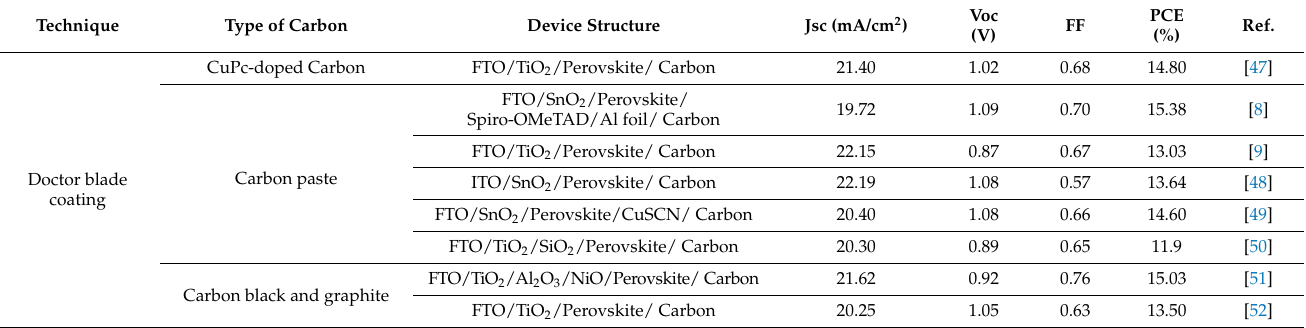
Table 1. Summary of several techniques for fabrications of carbon electrodes in perovskite solar cells. Technique Type of